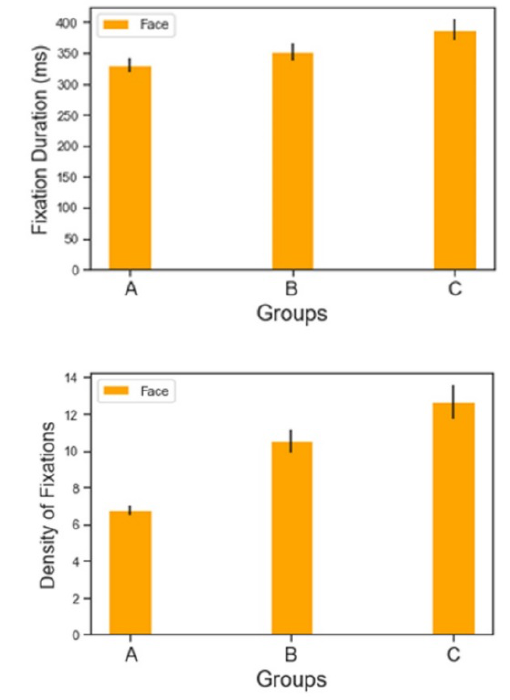
Figure 6.1, 6.2: Fixation duration (ms) and density of fixations across groups for AOI